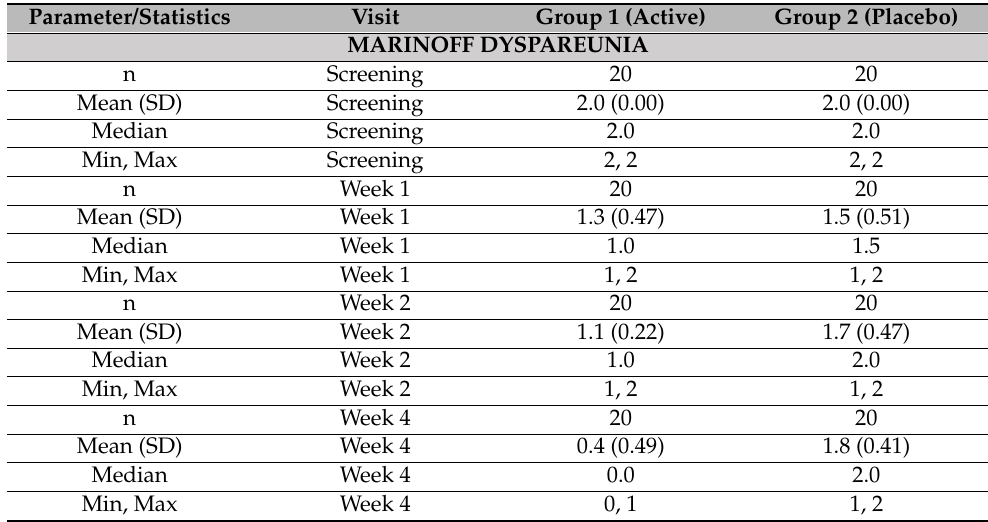
Table 3. Reduction of Marinoff dyspareunia from screening to week 1, week 2 and week 4.